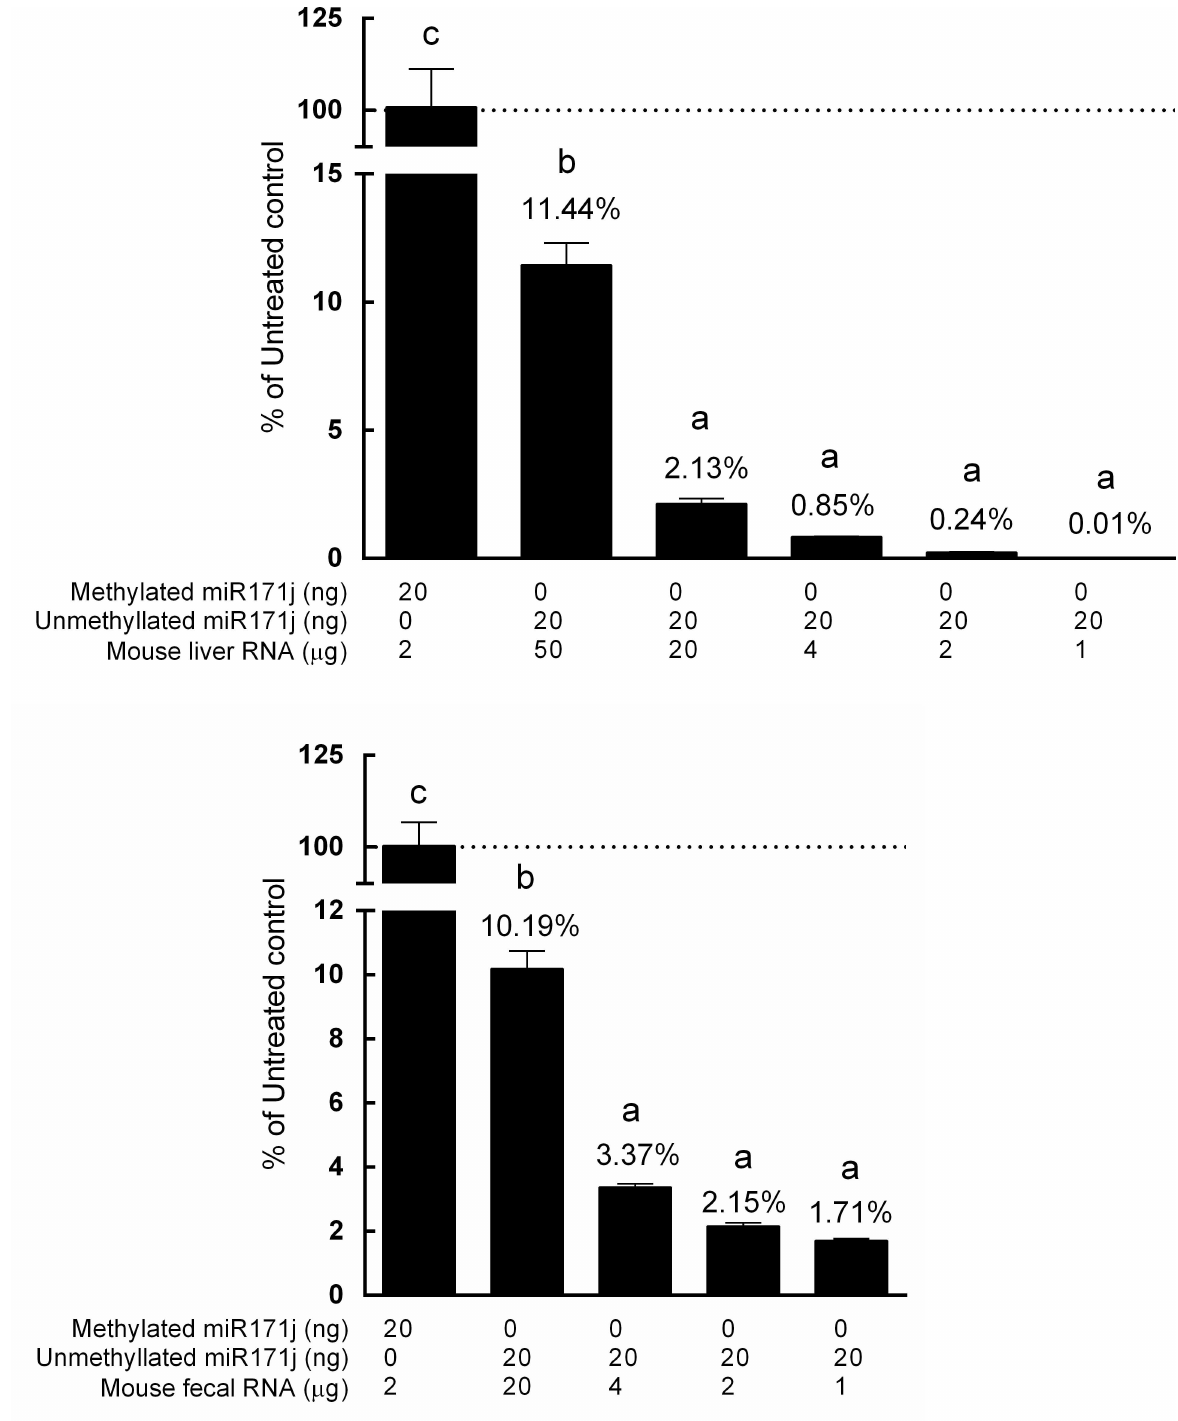
Fig 7. Evaluation of internal control in mammalian RNA matrix. 20 ng of methylatedmiR171jor 20 ng of unmethylated miR171j were added to A) 1 μ g to 50 μ g of mouse liver total RNA or B) 1 μ g to 20 μ g of mouse fecal total RNA treated with or without periodate, followedby β elimination, and analyzedby qRT-PCR as describedin Materials and Methods. Data is presented as a percentage of miR171jdetected in the treatment group to that of the control group. Columnsmarked with different letters are significantly different from each other ( p (cid:20) 0.05, data presentedas Mean ±